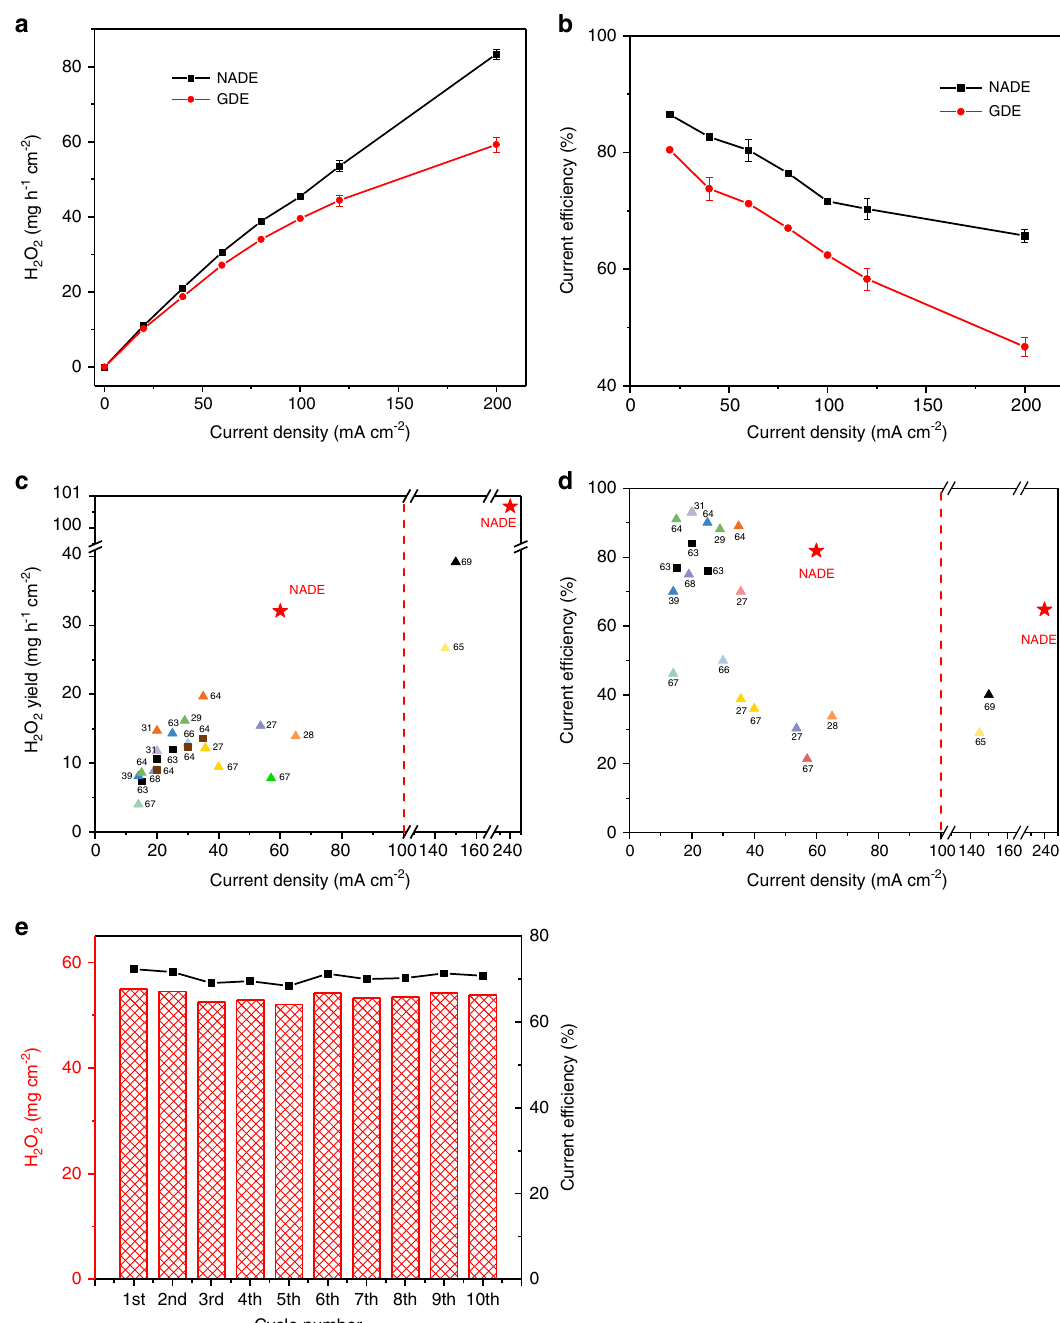
Fig. 5 Performance comparison with normal GDE and stability test. a Concentrations of H 2 O 2 and b current ef fi ciency comparisons of the NADE system and passive diffusion GDE (supply air at a fl ow rate of 0.5 L min − 1 ) at different current densities. Comparison of c H 2 O 2 yield and d current ef fi ciency with the literature. e The stability test of the NADE system in 10-times (20 h) continuous runs. The error bars in a , b represent the standard deviation of three independent samples. Source data are provided as a Source Data fi